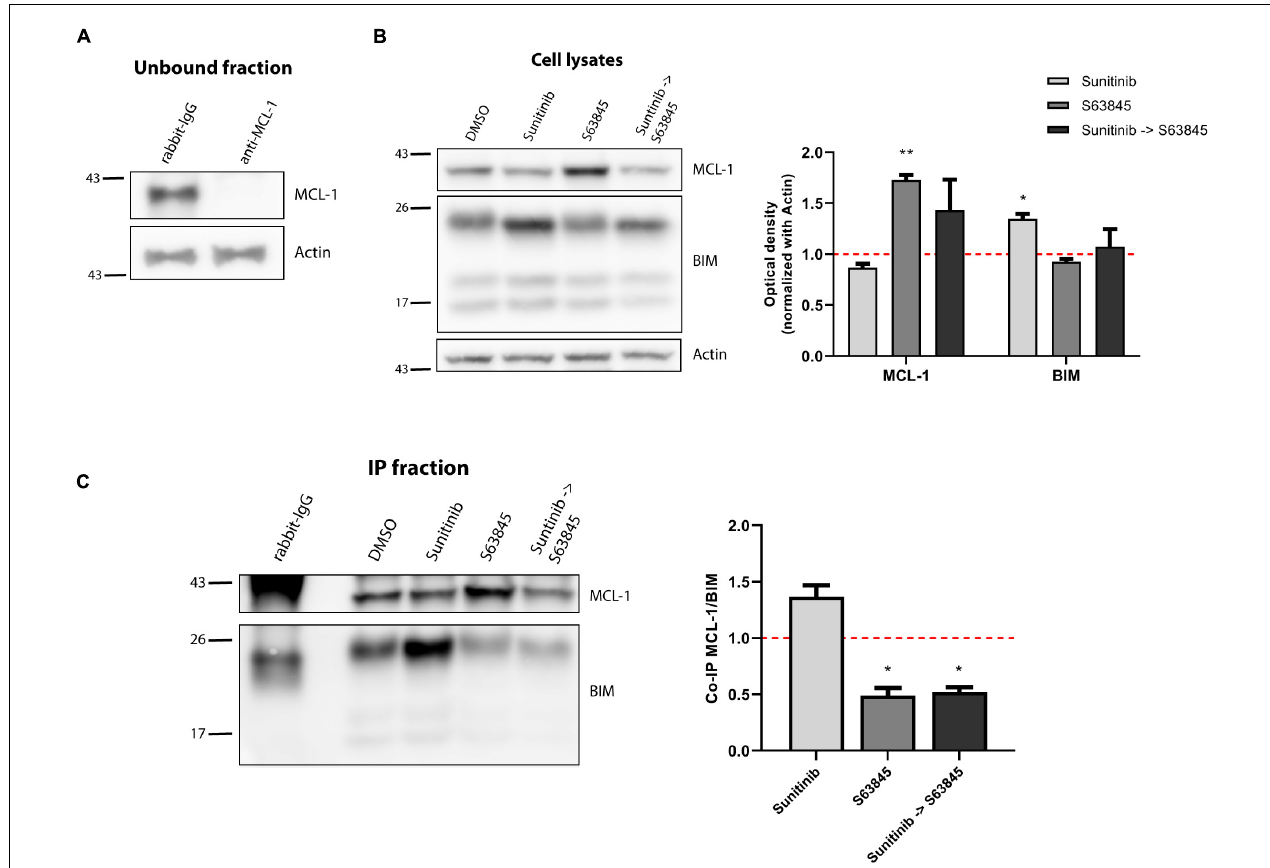
FIGURE 5 | Increased binding of BIM to MCL-1 causes sunitinib and S63845 synergism. (A) Western blot analysis of the unbound fraction after MCL-1 immunoprecipitation. (B) Immunodetection of MCL-1 and BIM initial expression in cell lysates after 16 h of incubation with sunitinib 100 nM, and 2 h incubation with S63845 100 nM in the specified conditions. Quantification of optical density for each protein was normalized to actin and fold-change was calculated comparing to protein expression in the control condition. (C) Western blot of the immunoprecipitated fraction was used to study the interaction between MCL-1 and BIM after treatment with sunitinib 100 nM and 2 h with S63845 100 nM. To quantify this binding, BIM optical density was normalized to MCL-1 optical density and fold-change was calculated comparing to protein expression in the control condition. All results are expressed as the mean ± SEM of at least three biologically independent replicates. Statistical significance was calculated using Student’s t -test compared to control condition and considering * p < 0.05 and ** p <